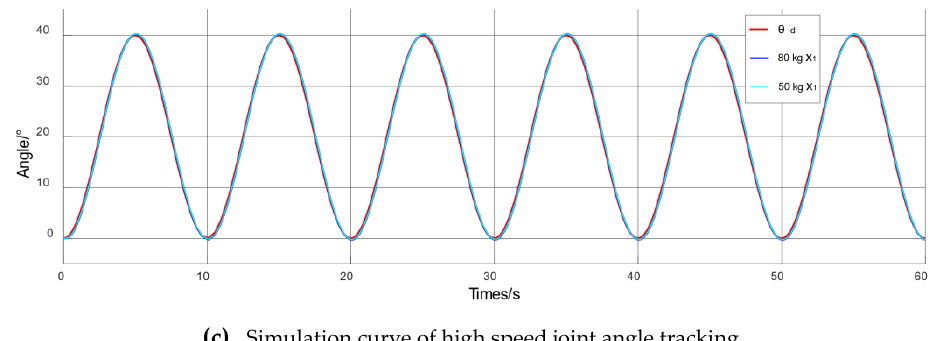
Figure 8. Simulation curve of equal amplitude variable frequency sinusoidal signal. 5. Passive Training Experiment of Elbow Rehabilitation Robot 5.1. Experiment on Safety Performance of Passive Training The experimental system consists of four parts: air source system, drive system, con- trol system, and mechanical system. We choose the embedded controller CX2040 from Beckhoff in Germany, the CHA38B6-12B-GDC24R1 single-turn absolute encoder pro- duced by Changchun Changhui Optoelectronics Technology Co., Ltd., and the propor- tional pressure regulating valve ITV2050-212N from SMC in Japan. First, in the passive training safety experiment, the periodic angle signal 𝜃 𝑑 (𝑡) = 17.5 sin ( 𝜋𝑡 15 − 𝜋 2 ) + 22.5 is given, with a cycle of 30 s and the movement angle ranging from 5 to 40°. As the passive training process starts slowly, the 5 s preparation time is reserved, when the elbow joint remains at 0° position. The process of rehabilitation training is shown in Figure 9, Steps 1–3 represent the process of extending the rehabilitation arm from the initial vertical state to the maximum angle, and Steps 4–6 represent the process of contracting the rehabilitation arm to the initial vertical state. The experimental effect curve is shown in Figure 10.